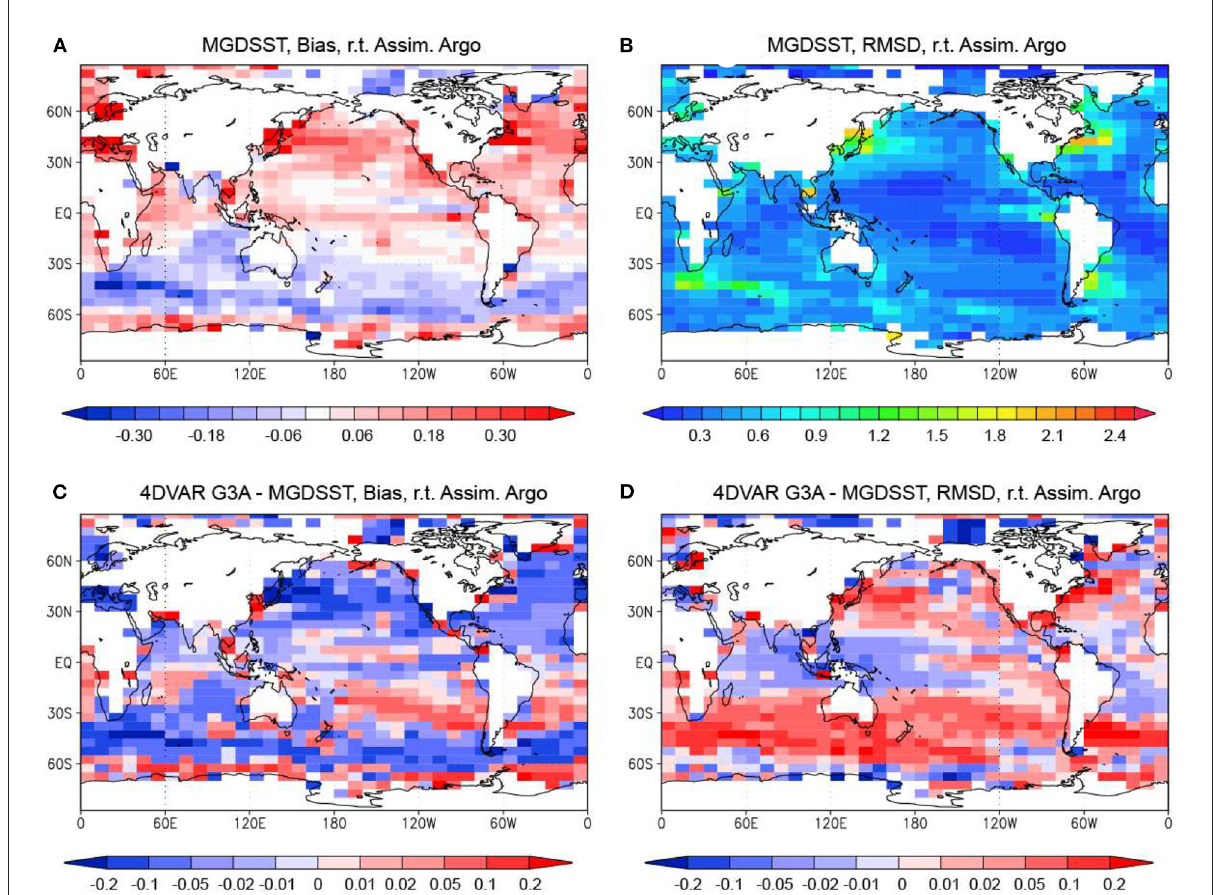
FIGURE3 Bias (A) and RMSD (B) of SST data from MGDSST, and differences of bias absolute values (C) and RMSDs (D) of the MOVE-G3A SST for the 4DVAR Run from those for the SST data from MGDSST. The biases and RMSDs are calculated using the assimilated Argo float data as the reference. Blue colors mean that the bias absolute value or the RMSD is smaller for the 4DVAR Run. Units in ◦